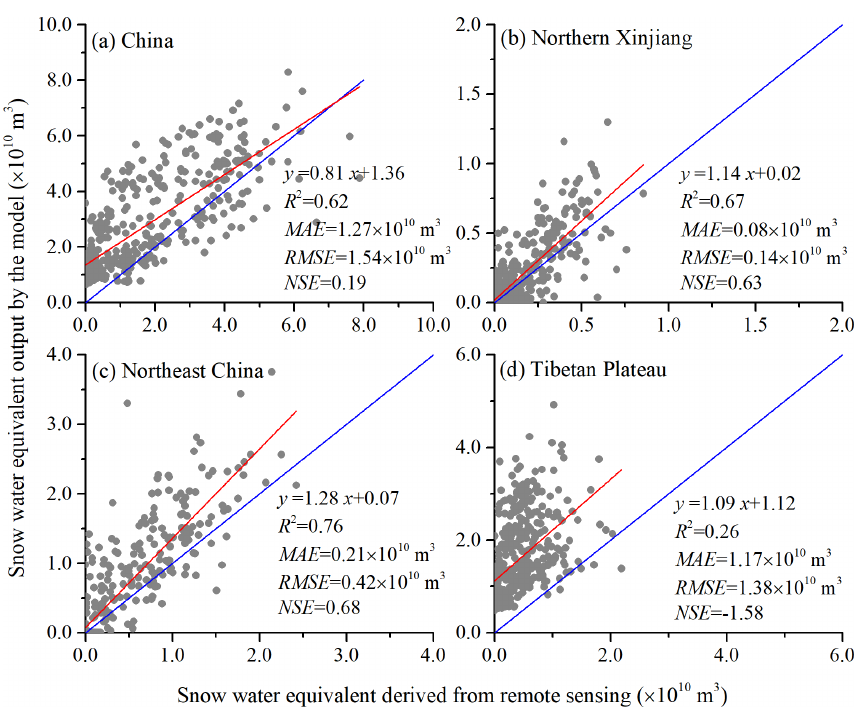
Figure 6. Scatterplots of the snow water equivalent output by the model and derived from remote sensing in China and its three main stable snow cover regions. The red and blue solid lines are the linear fit and the 1 : 1 line,